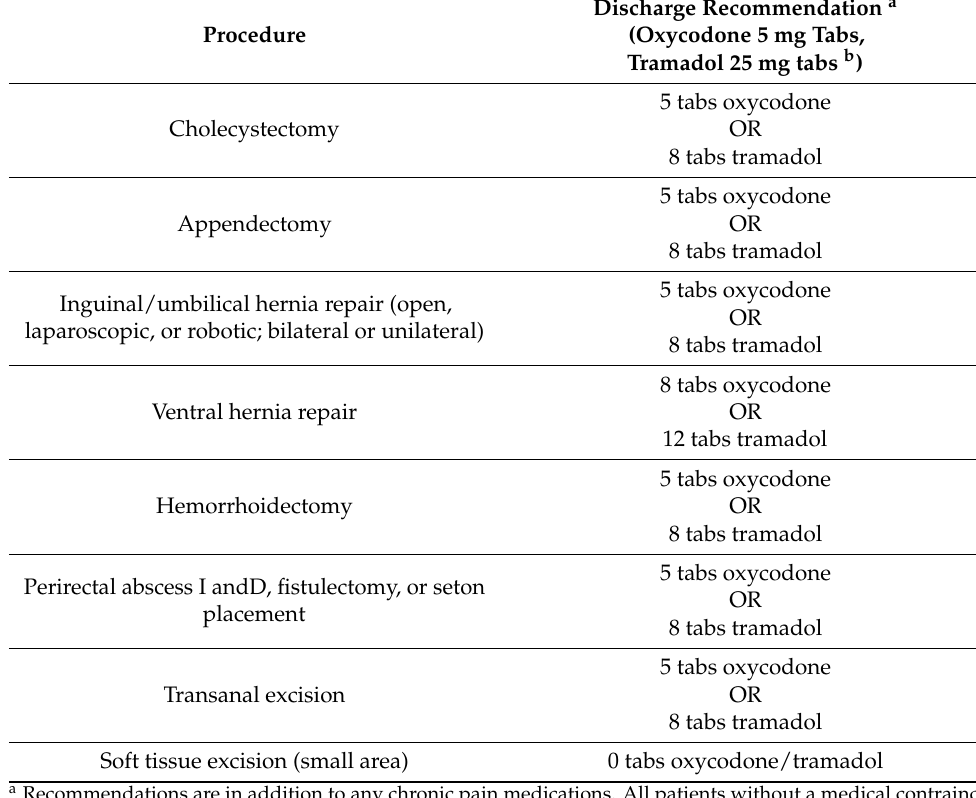
Table A2. VAPHS Opioid Prescribing Outpatient/Observation Guidelines: General Surgery.